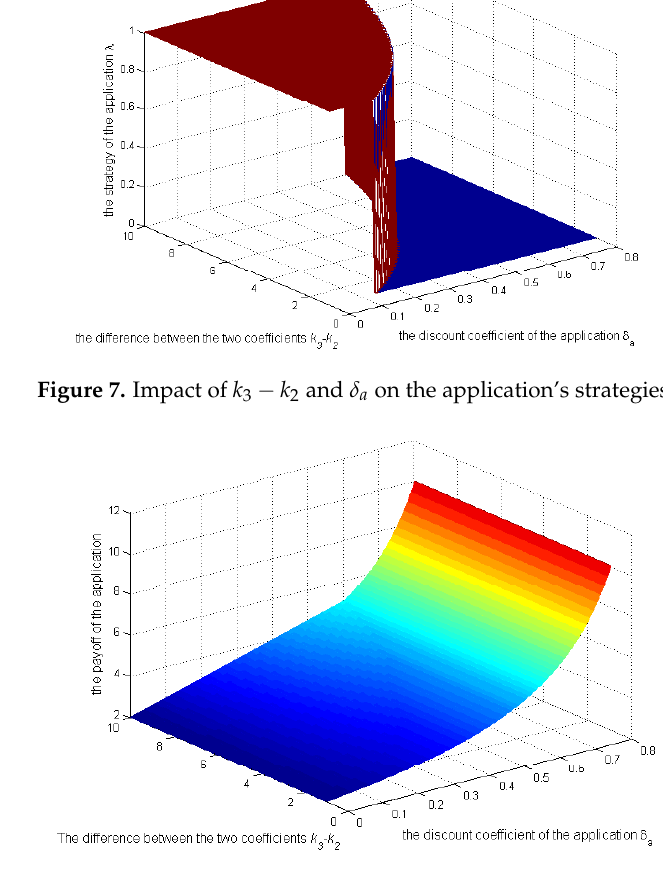
Figure 8. Impact of k 3 − k 2 and δ a on the application’s